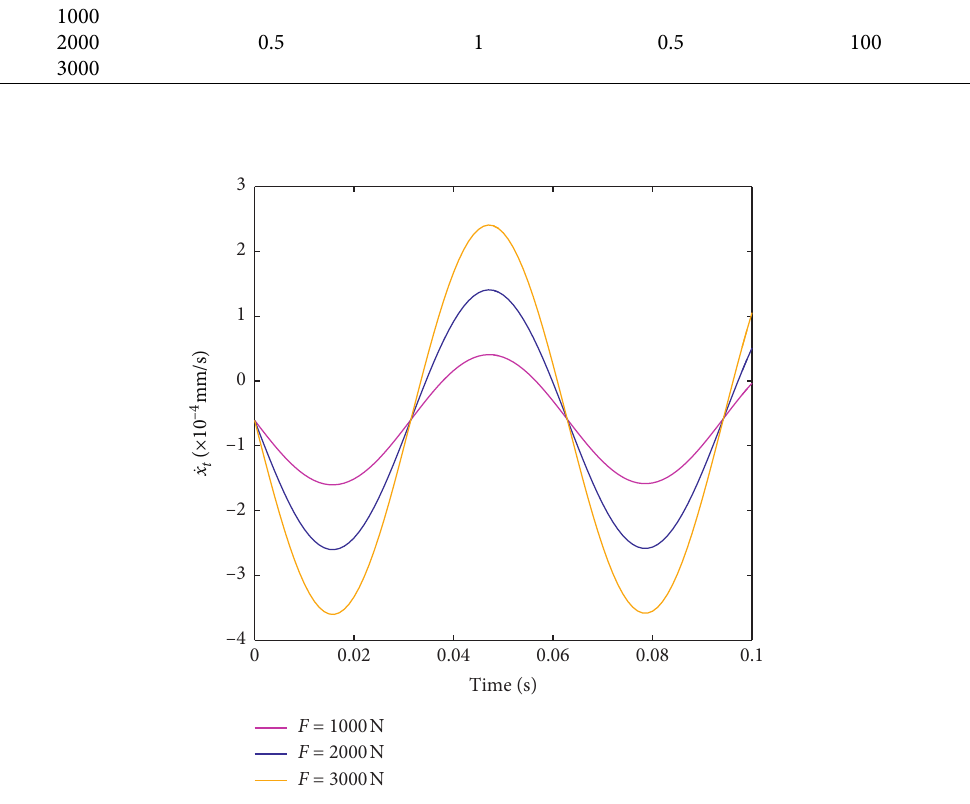
Figure 6: Changes of movement velocity of rock surface with time in different F